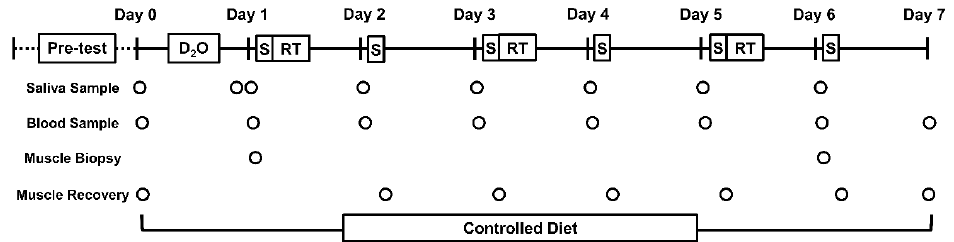
Figure 1. Study overview. D 2 O, deuterium oxide bolus (400 ml 70 atom %); RT, lower-body resistance-training session; S, supplement ingestion (0.33 g · kg · d − 1 whey protein or isonitrogenous control) tested in a randomised double-blind parallel-group design. Pre-test measures included physical / medical screen, familiarisation, body composition and dietary assessment. Biopsies were sampled from m. vastus lateralis. Muscle recovery was assessed via peak isometric squat force, countermovement jump height, lower-body muscle soreness and serum creatine kinase.